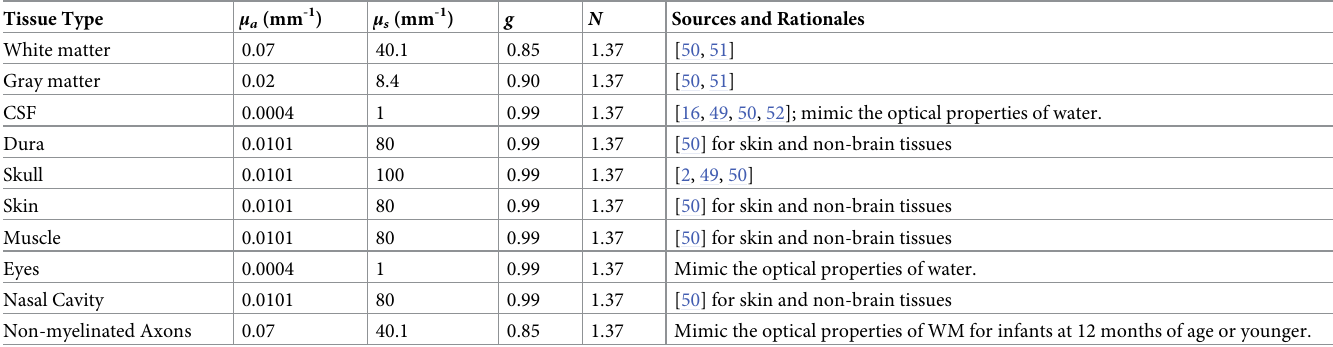
Table 2. Optical properties used in Monte Carlo photon migration simulations.